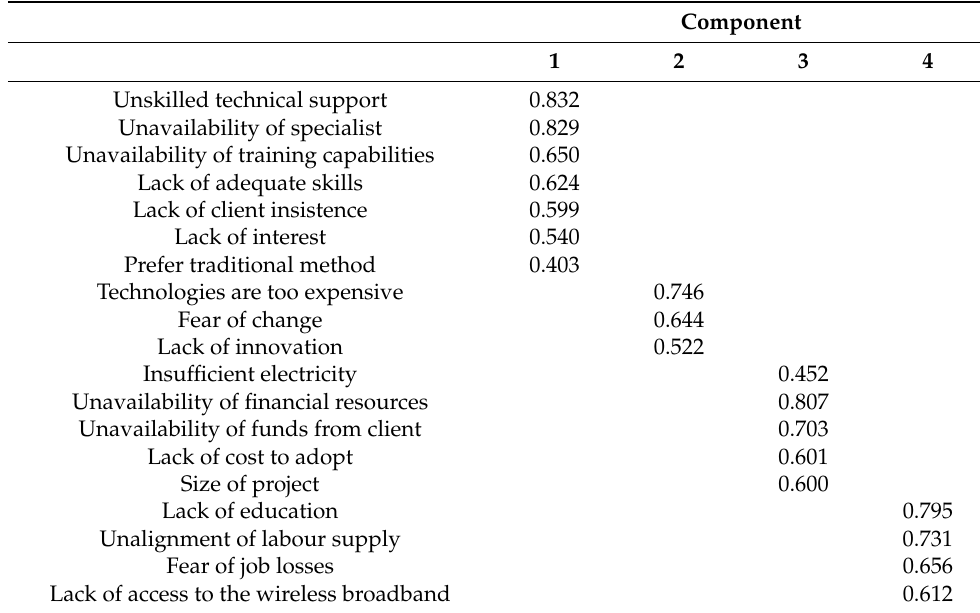
Figure 2. Scree plot for Challenges. Table 9. Pattern Matrix.